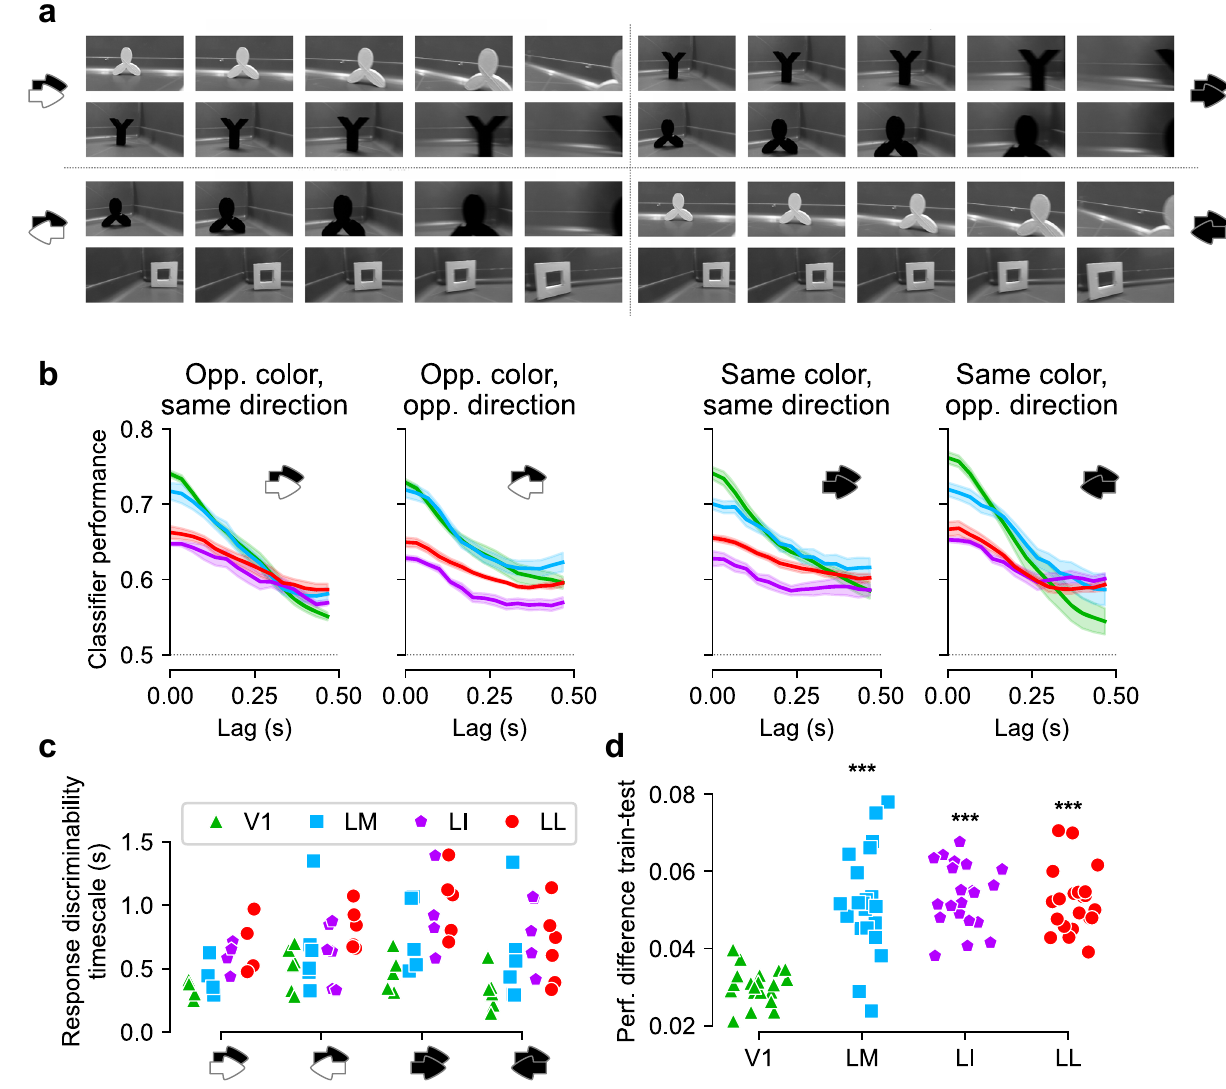
Fig. 6 Classi fi er analysis restricted to hand-matched pairs of movie segments. a Frames of four example pairs of movie segments (each pair is representative of one of the four classi fi cation conditions that were tested in our analysis). Each movie segment was exactly 29 frames long, and the frames shown here are frames number 1, 8, 15, 22, and 29 (left to right). As indicated by the black/white arrows in each quadrant, each pair of movie segments was distinguished from the others, based on whether the objects in the segments had the same color and whether they moved along the same direction. b Classi fi er performance vs. lag from the training bin for each of the four conditions. Solid line: average over all pairs tested in the task. Shaded area: s.e.m. c Timescales extracted from the decoding performances of all pairs of movies segments tested in any given classi fi cation task and for each area (two outlier data points are not shown: 3.65 s for same color/same direction, and 2.73 s for same color/opposite direction). d Amount of classi fi er performance due to intrinsic correlations (difference between performance on training trials and on test trials; as de fi ned in Fig. 5d) for each movie pair and each area. * p = 1e − 7, 7e − 10, 3e − 9 for LM, LI, LL, respectively, paired t -test on each area vs. V1. Source data are provided as Source Data fi